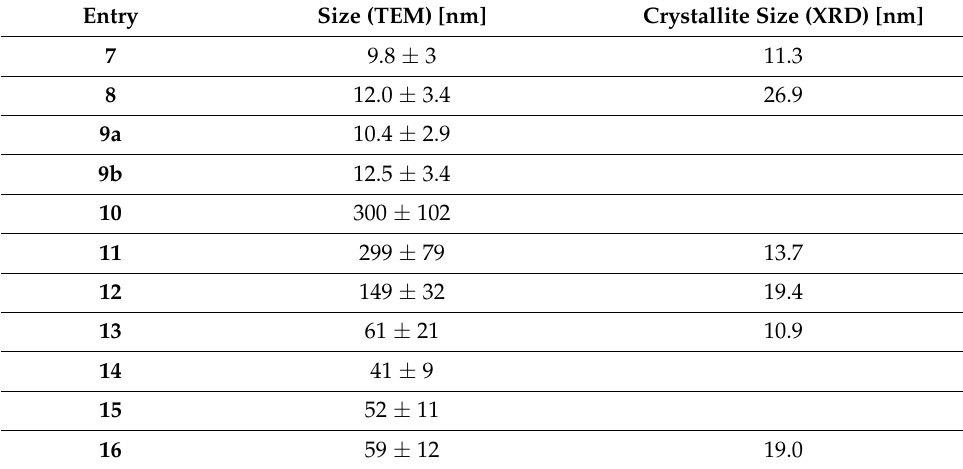
Figure 1. TEM of magnetite nanoparticles 8 (( a ), top left) and PMVP coated magnetite nanoparticles 7 (( b ), top right)—scalebars 100 nm, inset are the size distributions; FTIR spectra of 8 , 7 and 9a (( c ), bottom left); magnetization curves of 8 and 7 (( d ), bottom right). Table 1. Average size of the particles and clusters as measured from TEM, and crystallite size as determined by the Scherrer equation